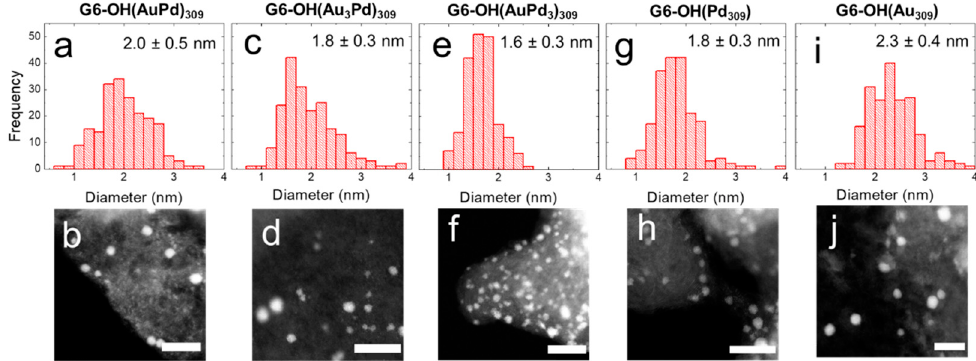
Figure 1. Size-distribution histograms and representative ac-STEM micrographs for conductive Figure 1. Size ‐ distribution histograms and representative ac ‐ STEM micrographs for conductive inks containing as ‐ prepared ( a , b ) G6 ‐ OH(AuPd) 309 ; ( c , d ) G6 ‐ OH(Au 3 Pd) 309 ; ( e , f ) G6 ‐ OH(AuPd 3 ) 309 ; ( g , h ) inks containing as-prepared ( a , b ) G6-OH(AuPd) 309 ; ( c , d ) G6-OH(Au 3 Pd) 309 ; ( e , f ) G6-OH(AuPd 3 ) 309 ; G6 ‐ OH(Pd 309 ); and ( i , j ) G6 ‐ OH(Au 309 ) DENs. The scale bar is 10.0 nm. ( g , h ) G6-OH(Pd 309 ); and ( i , j ) G6-OH(Au 309 ) DENs. The scale bar is 10.0